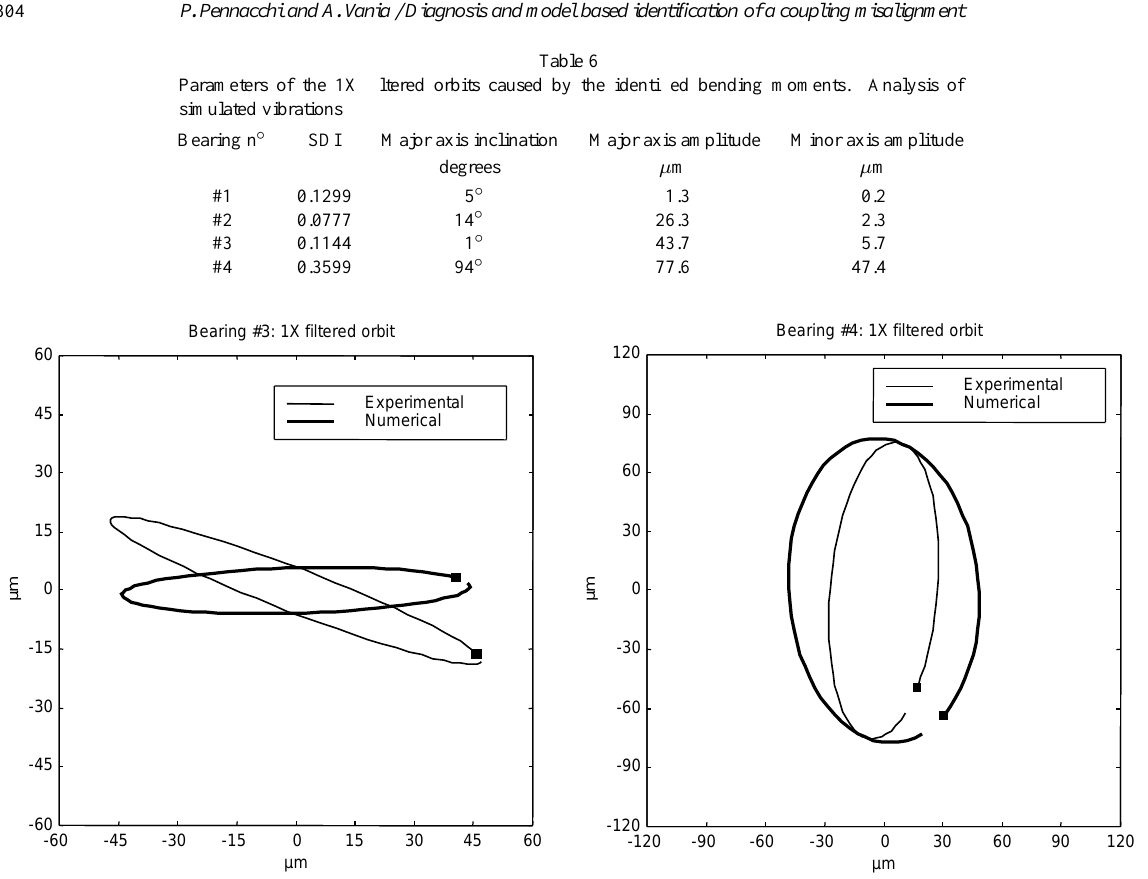
Fig. 9. 1X filtered orbit induced by the fault on bearing #3 and #4 (generator). Comparison between experimental data and numerical